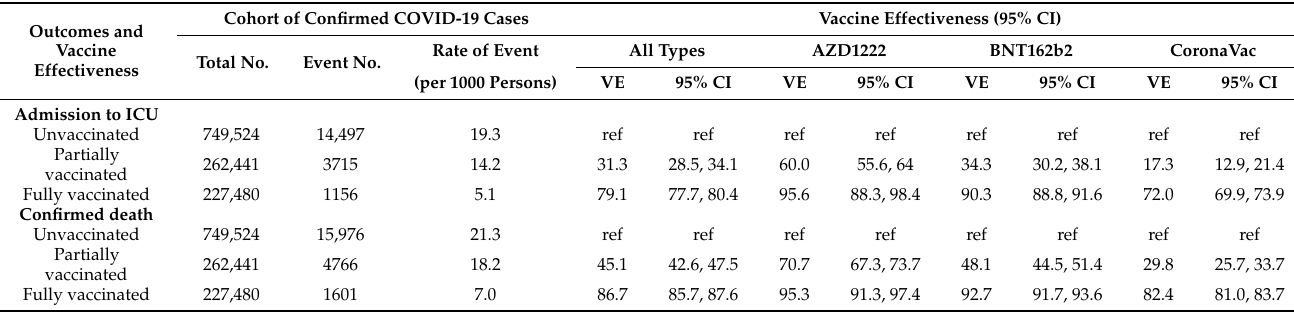
Table 3. Vaccine effectiveness in preventing admission to ICU and deaths among COVID-19 cases, according to types of vaccines and vaccination status.